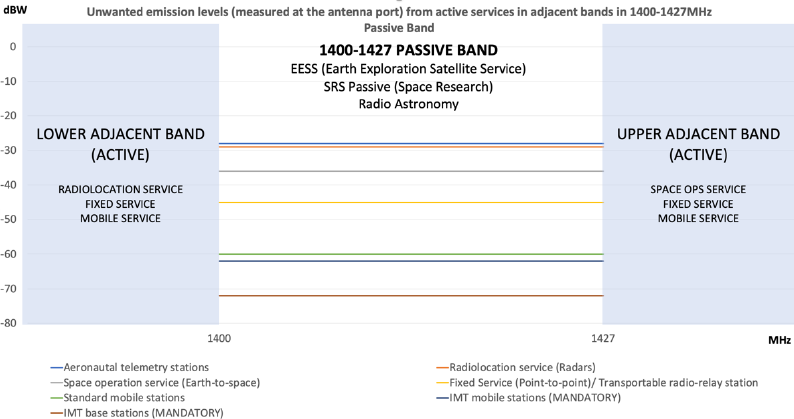
Figure 2. Unwanted emission level (measured at the antenna port) from active services in adjacent bands in 1400 – 1427 MHz passive band defined by the ITU-R Resolution 750 (Rev. WRC-19).